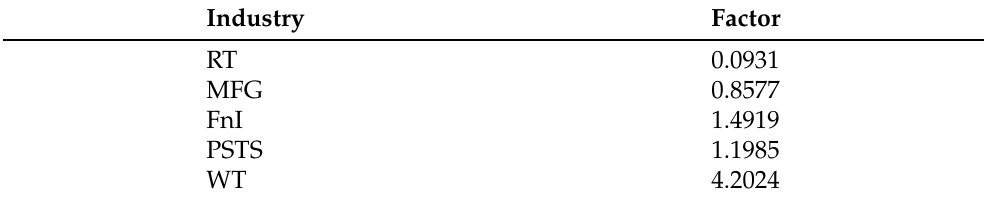
Table 2. Under-reporting Factors: Industry.